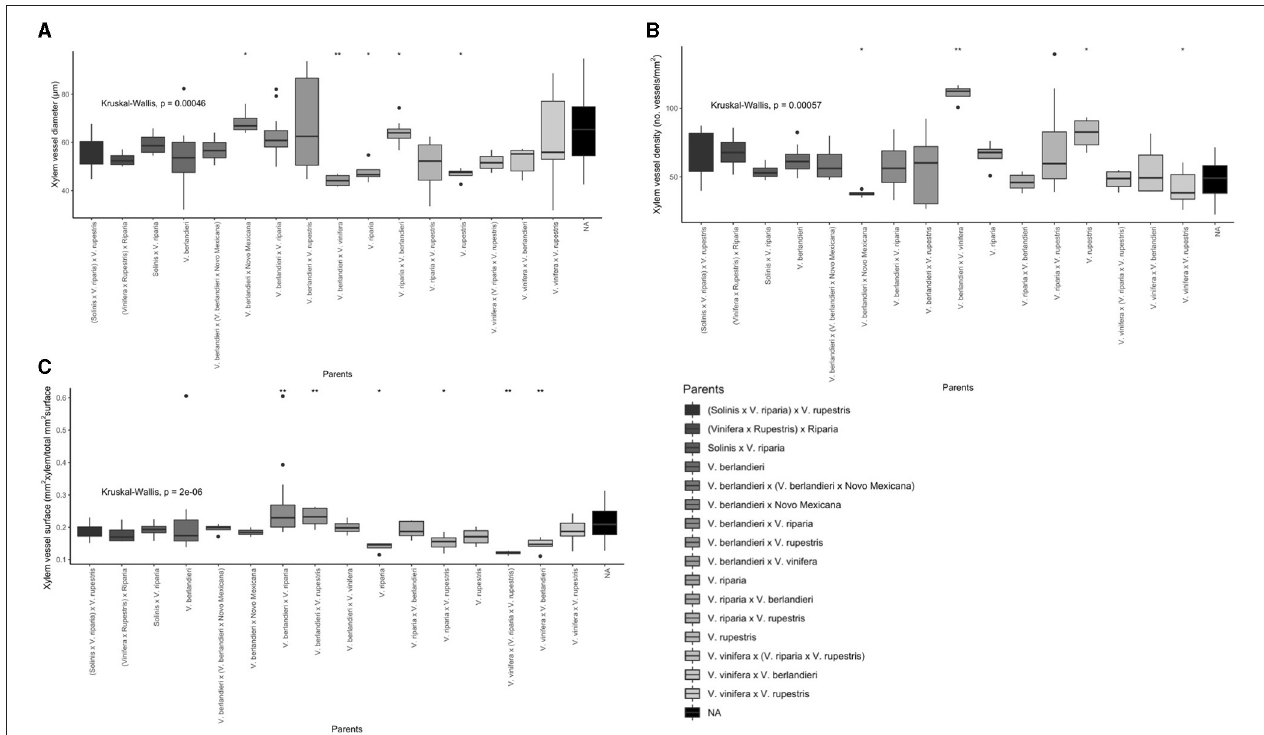
FIGURE 5 | Box plots of the histological traits for each rootstock parent cross (Solinis = V. longii ). (A) Xylem vessel diameter ( µ m). (B) Xylem vessel density (number of vessels/mm 2 xylem). (C) Proportion of stem surface area covered by xylem vessels (mm 2 xylem vessels/total mm 2 vascular surface area). Significance (* P < 0.05, ** P < 0.01) determined by the Wilcoxon rank sum